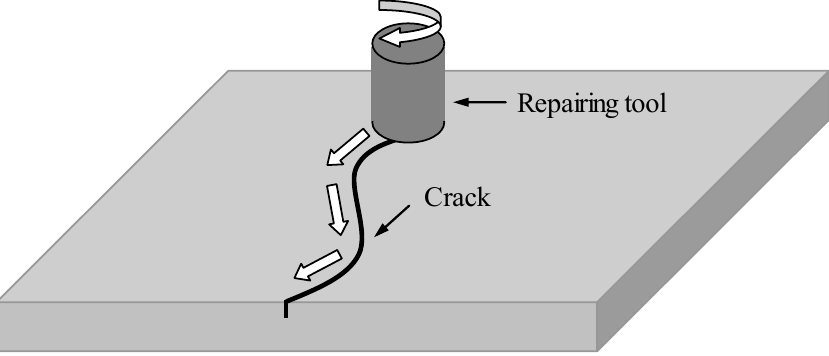
Figure 1. Outline of friction stir crack repairing principle.